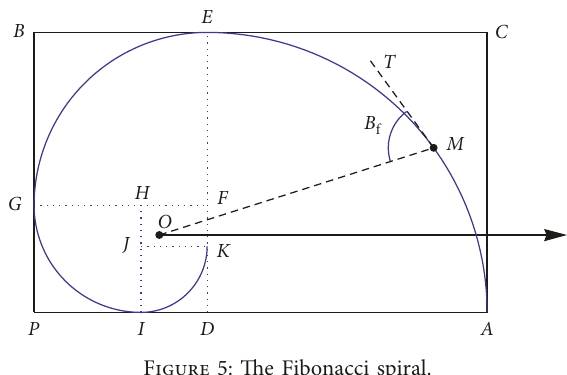
Figure 5: The Fibonacci